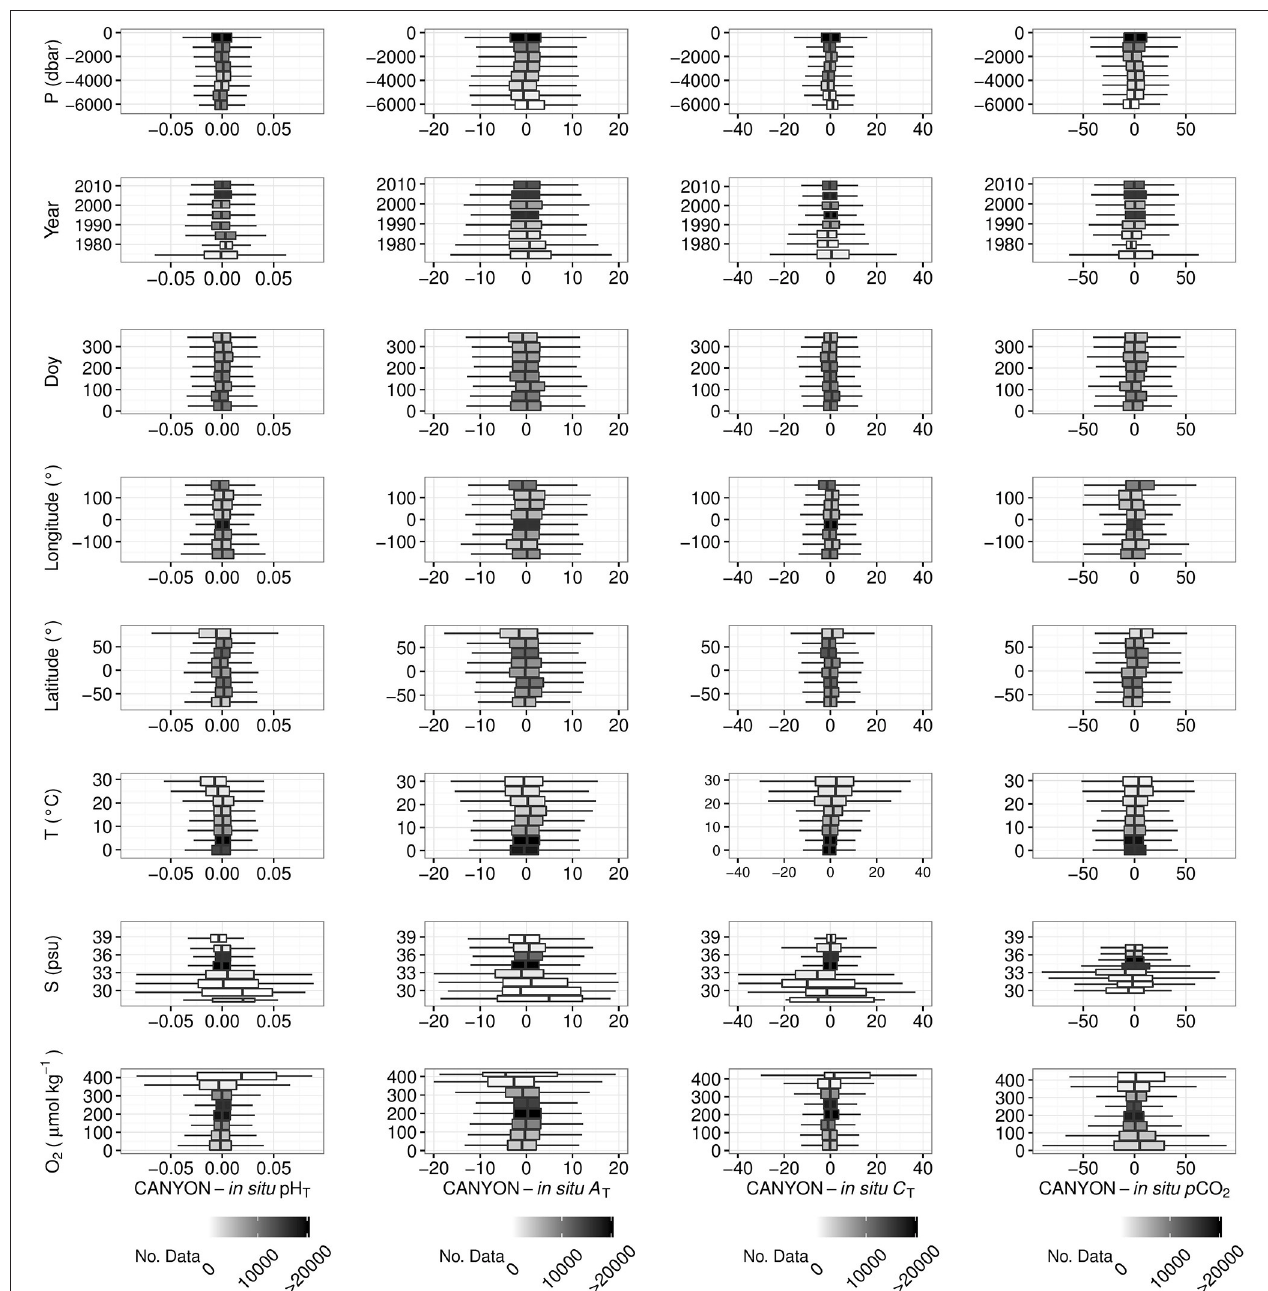
FIGURE 5 | Box plots of the difference between CANYON estimates minus GLODAPv2 reference measurements for (from left to right) pH T , A T ( µ molkg − 1 ), C T ( µ molkg − 1 ), and p CO 2 ( µ atm) vs. the variable indicated on the left: pressure (P), year, doy, longitude, latitude, temperature (T), salinity (S), O 2 . The intensity of the shading in each box refers to the number of data. The intervals were created by sharing the range of values in eight regular intervals. For each box, the lower and upper whiskers represent the Q1–1.5*IQR and Q3 1.5*IQR, respectively, with Q1 the 0.25 quantile, Q3 the 0.75 quantile and + IQR the inter-quantile range. The width of each box represents the IQR and the middle line the median of the values.